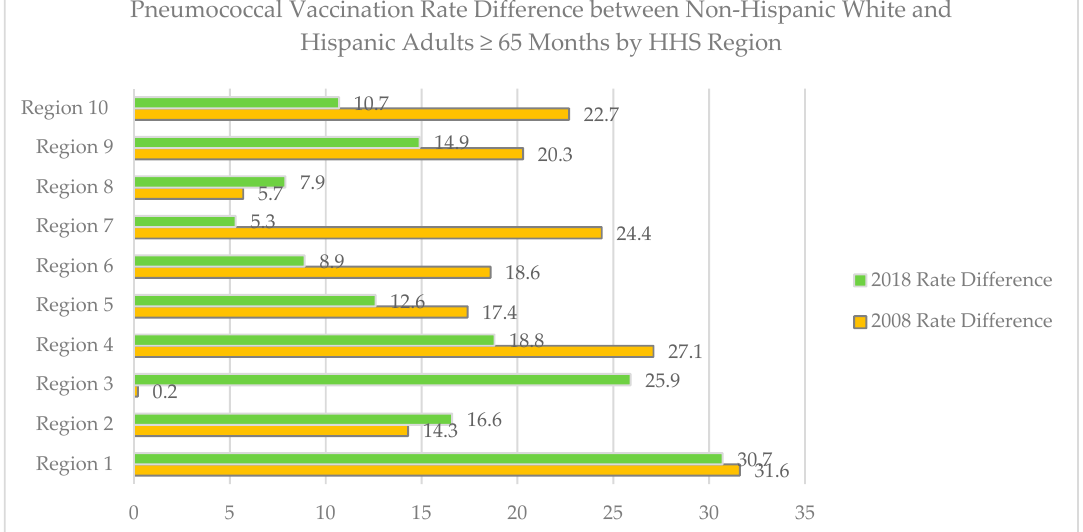
Figure 3. Difference in pneumococcal immunization rate between non-Hispanic white and Hispanic adults aged ≥ 65 years by HHS Region in 2008 and 2018 (Source BRFSS). X-axis units are percentages.